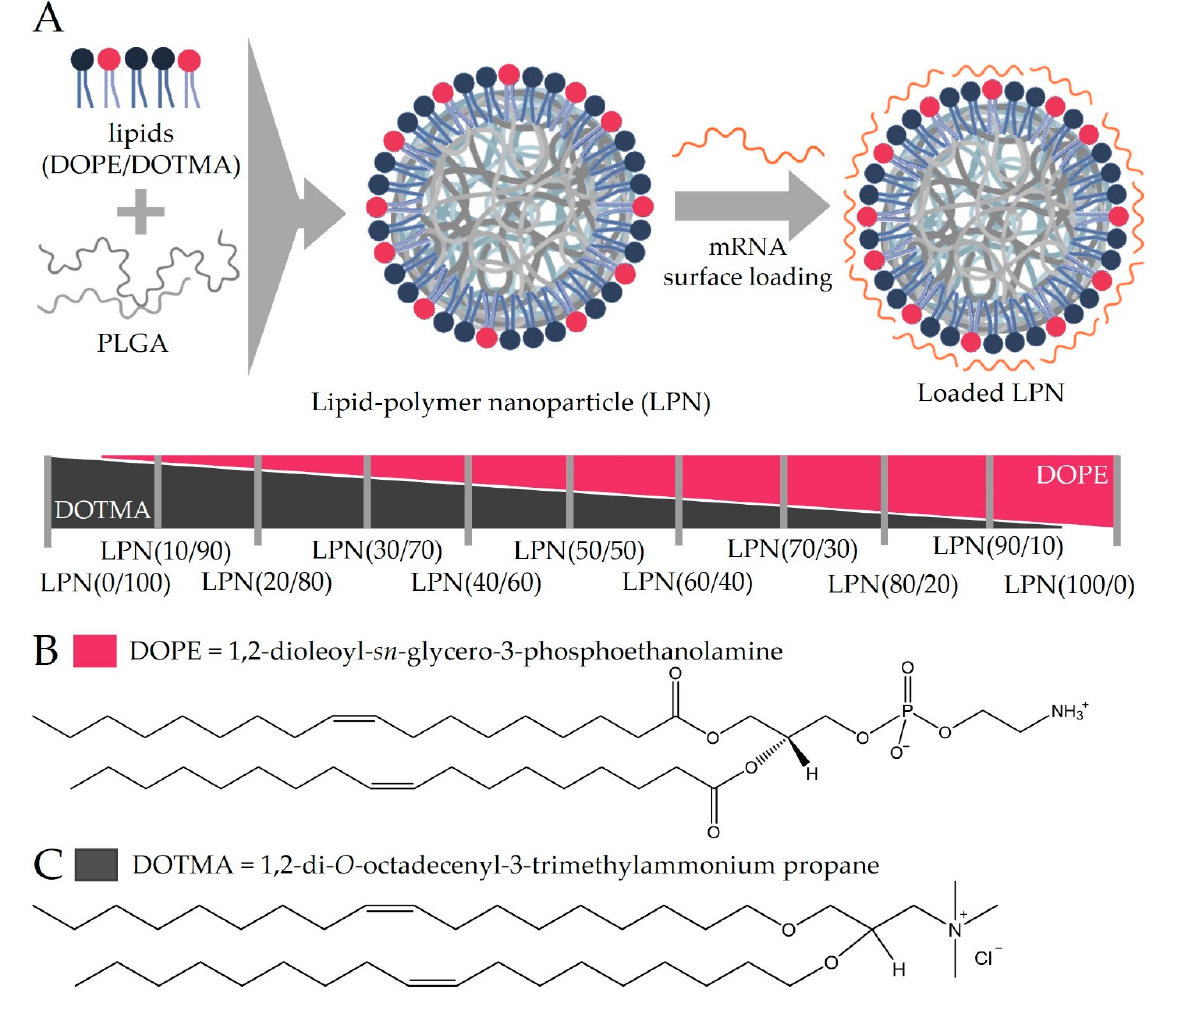
Figure 1. ( A ): Anticipated nanocarrier structure. The values in brackets represent the molar percent- age of each lipid that is present in the lipid layer. The first number refers to the DOPE, the second to the DOTMA content. ( B ): structure of DOPE (1,2-dioleoyl- sn -glycero-3-phosphoethanolamine), ( C ): structure of DOTMA (1,2-di- O -octadecenyl-3-trimethylammonium propane).